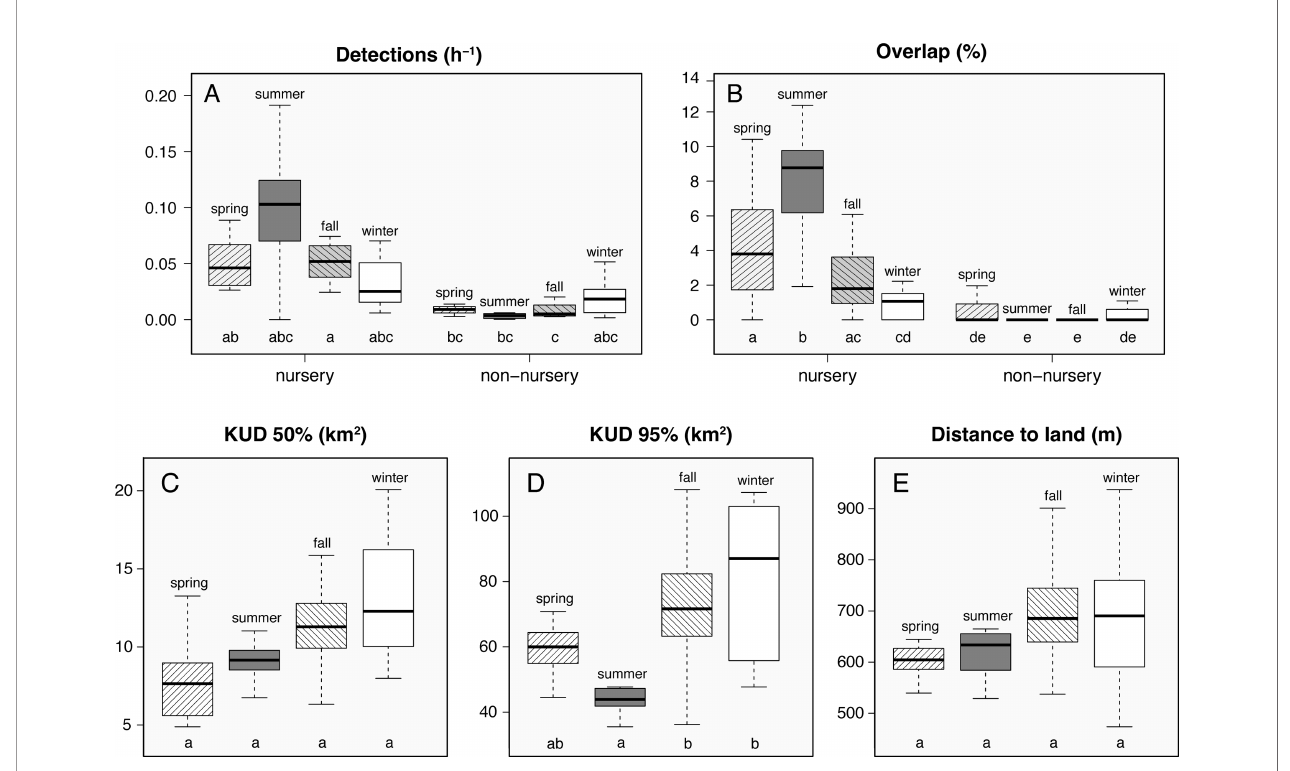
FIGURE 6 | Detection frequency of smooth hammerhead shark ( Sphyrna zygaena ) (detections h-1; A ), overlap (%; B ), distance to nearest land surface (m; C ), core activity areas (km 2 ; D ), and home range areas (km 2 ; E ) estimated per season. Boxes ’ upper and lower limits represent the 75th and 25th quartiles, horizontal lines represent medians, and whiskers represent values within 1.5 interquartile ranges; outliers were removed in order to simplify visual interpretation; lowercase letters below the boxes represent signi fi cance groupings after a pairwise comparison (using Bonferroni correction) where groups sharing the same letter are not signi fi cantly different at p < 0.05.